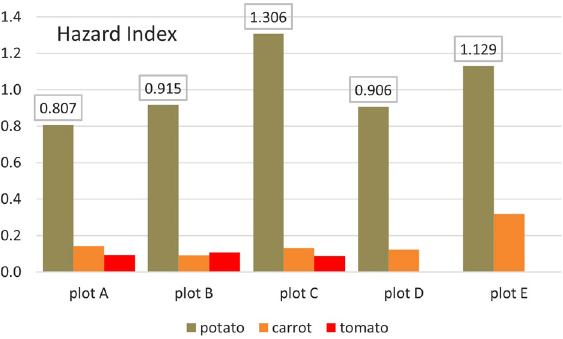
Figure 7. Hazard index (HI) of all heavy metals (Fe, Mn, Zn, Cu, Ni, Pb, and Hg) in potatoes, carrots, and tomatoes grown on individual